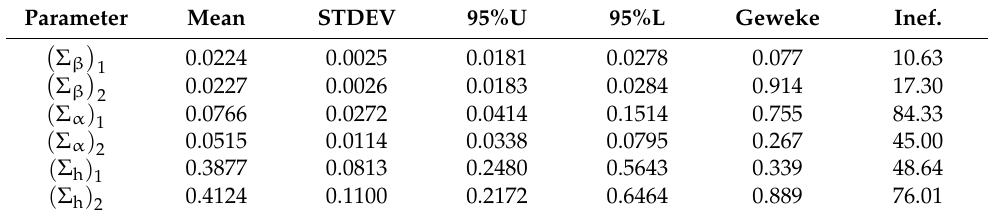
Table 4. The estimation results of MCMC simulation